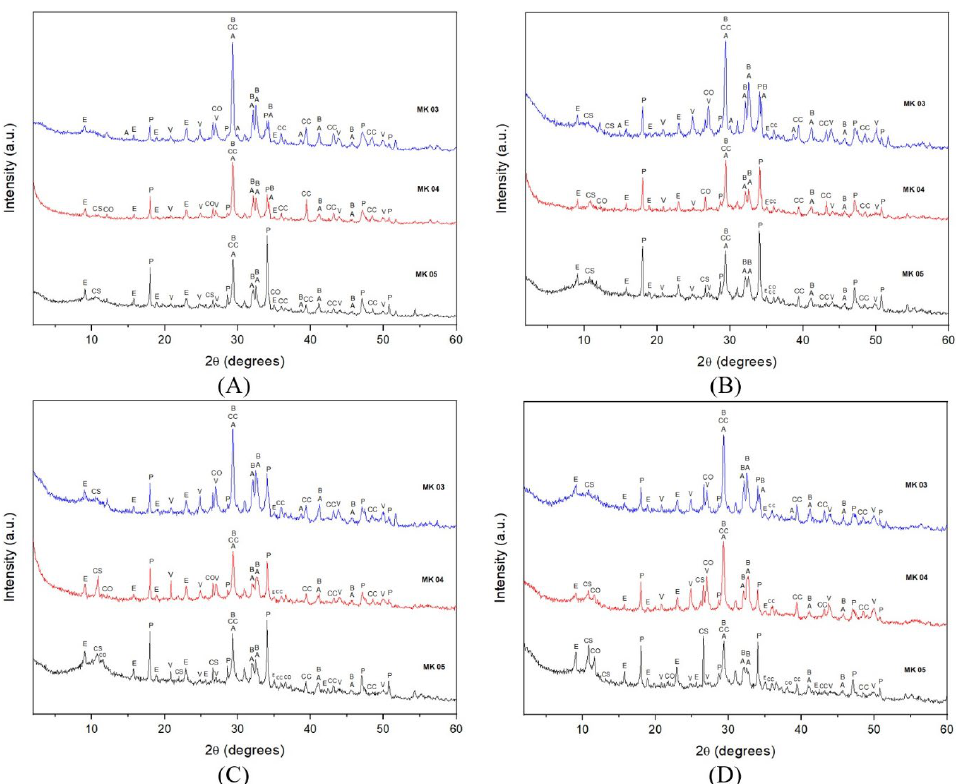
Figure 8. Diffractograms of the cementitious pastes with the replacement of Portland cement by 20% of metakaolin, with 1 day (A), 3 days (B), 7 days (C), and 28 days (D) of hydration. E- Ettringite, P-portlandite, V-vaterite, A-alite, CC-calcite, B-belite, CS- hydrated calcium aluminum silicate, CO-hydrated calcium aluminum